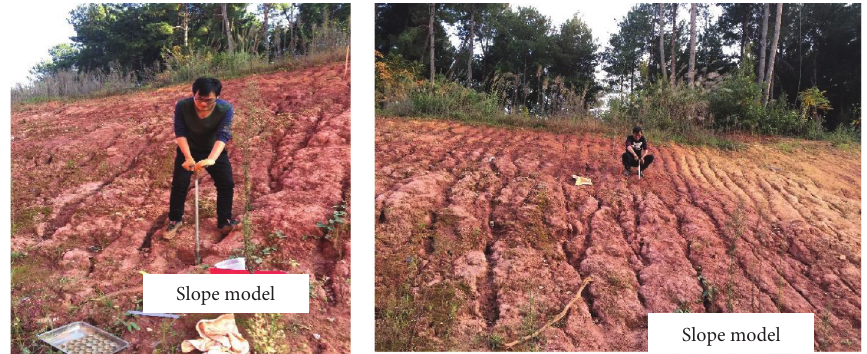
Figure 12: Failure characteristics of red clay slope.